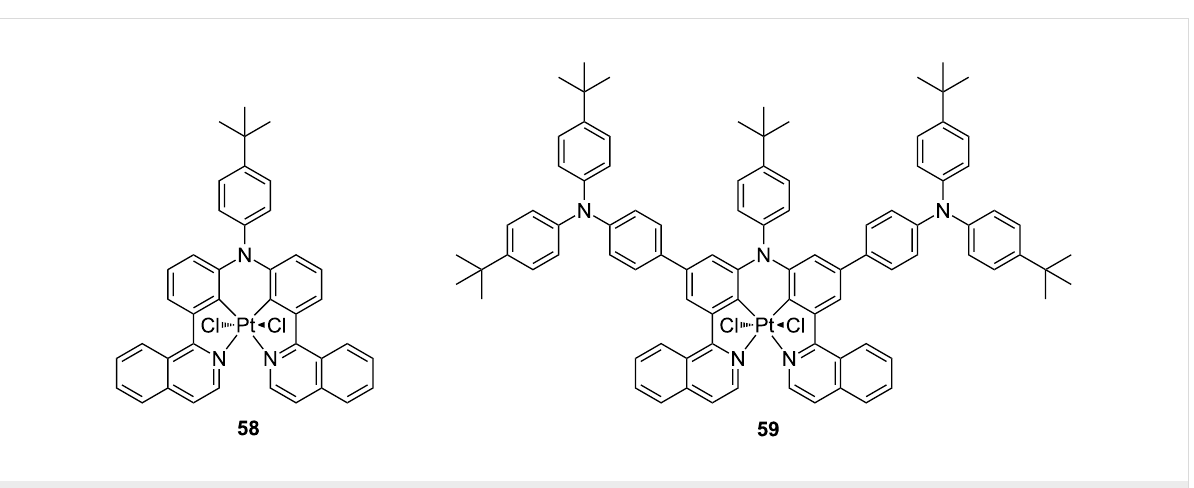
Figure 24: Molecular structures of the Pt(IV) derivatives 58 and 59 employed as triplet emitters in solution-processed OLEDs